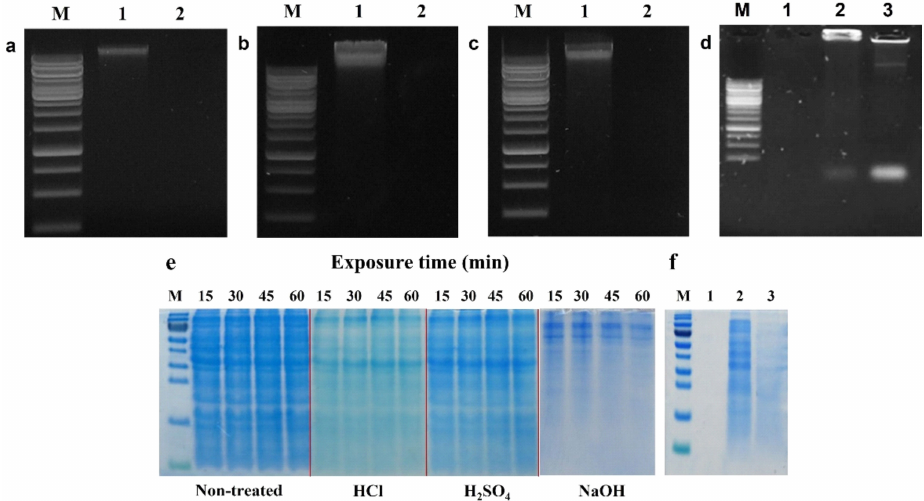
Figure 2. Agarose gel (1%) electrophoresis of genomic DNAs extracted from LMGs chemically induced by ( a ) HCl; ( b ) H 2 SO 4 ; ( c ) NaOH (lane 1, wild-type L. monocytogenes ; and lane 2, chemically induced LMGs); and ( d ) concentrated DNA from culture supernatants of wild-type L. monocytogenes (lane 1); HCl- (lane 2); and NaOH-induced LMGs (lane 3). M, 1 kb Marker Ladder. ( e ) During LMGs production, proteins were extracted from wild-type L. monocytogenes , and HCl-, H 2 SO 4 -, and NaOH-induced LMGs at 15, 30, 45, and 60 min. Each lane was loaded with 10 µ g of proteins. M: Protein Marker. ( f ) Remaining proteins in culture supernatants from wild-type L. monocytogenes (lane 1); HCl- (lane 2); and NaOH-induced LMGs (lane 3). Except for lane 1 (0.15 µ g), lanes 2 and 3 were loaded with 2.7 µ g of